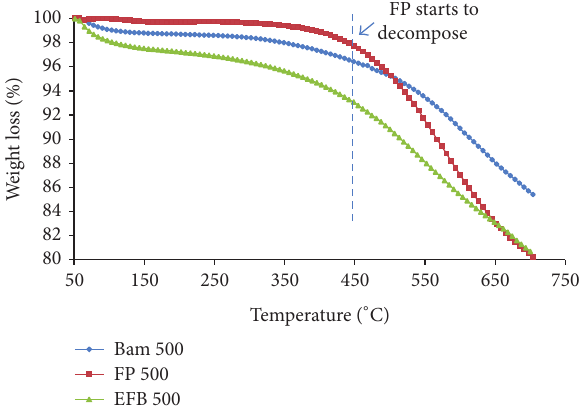
F 7: TGA analyses for bamboo, FP, and EFB carbons from carbonization